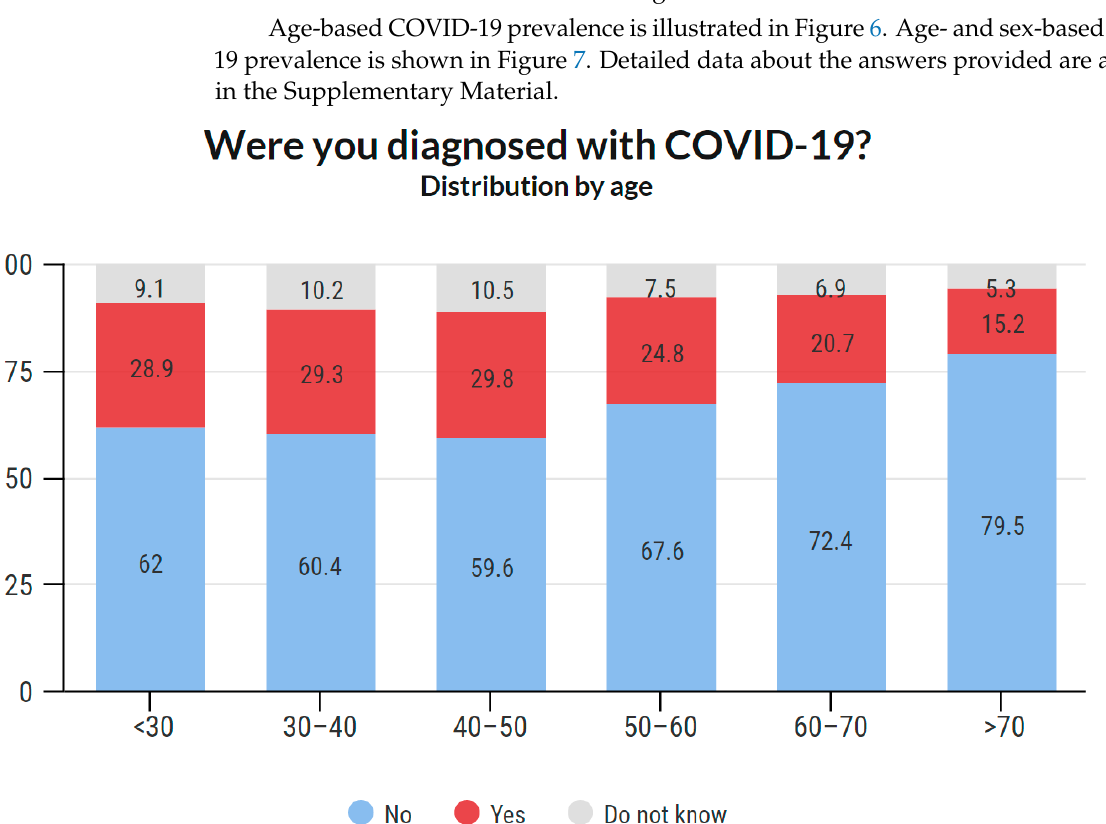
Figure 6. COVID-19 positivity, age distribution.